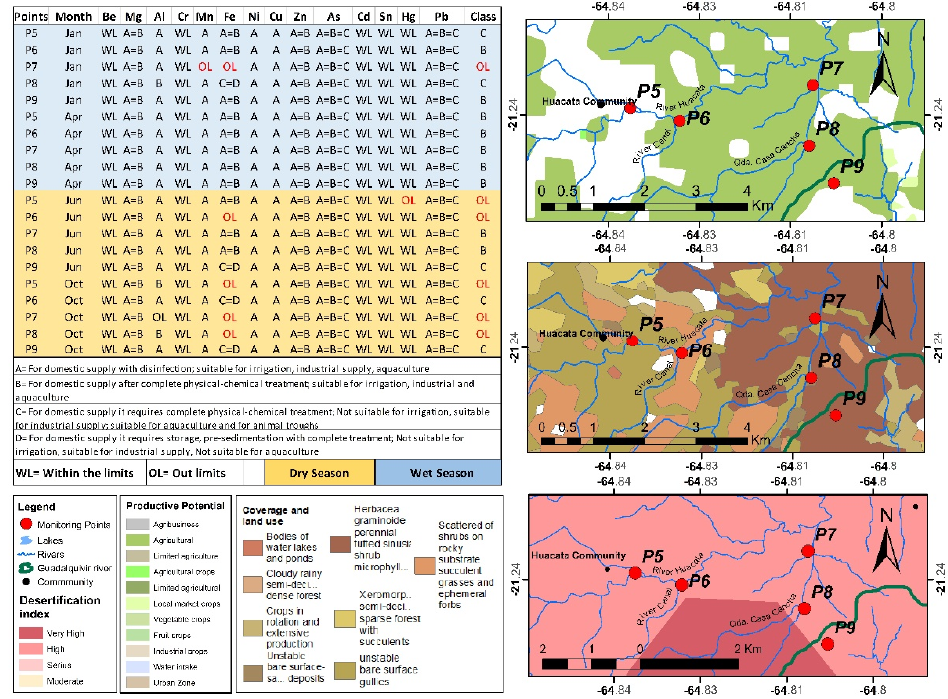
Figure 10. Water quality classification in the monitored points in Huacata. 3. Water quality in the Central Guadalquivir area In this area, six points were monitored, which can be seen in Figure 11.